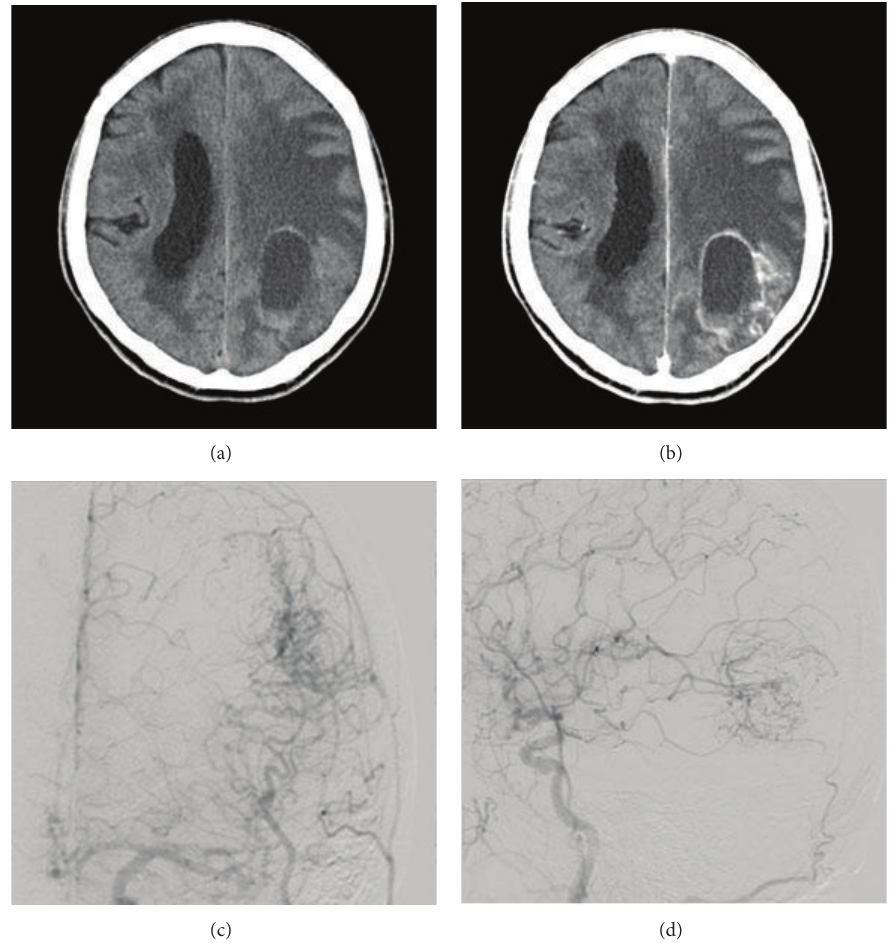
Figure 1: (a) Axial nonenhanced CT scan on admission shows a sharply marginated mass of 6.6 cm in diameter in the left temporal and parietal lobes and compressing the surrounding parenchyma. The left lateral cerebral ventricle is compressed. The lesion had a high-density region in the dorsal aspect indicating hemorrhage. (b) Axial enhanced CT image shows a massive lesion like a cyst with enhancement. (c) Digital subtraction angiography (DSA) of the frontal view shows tumor staining via the middle cerebral artery. (d) DSA of the lateral view shows tumor staining and no arteriovenous